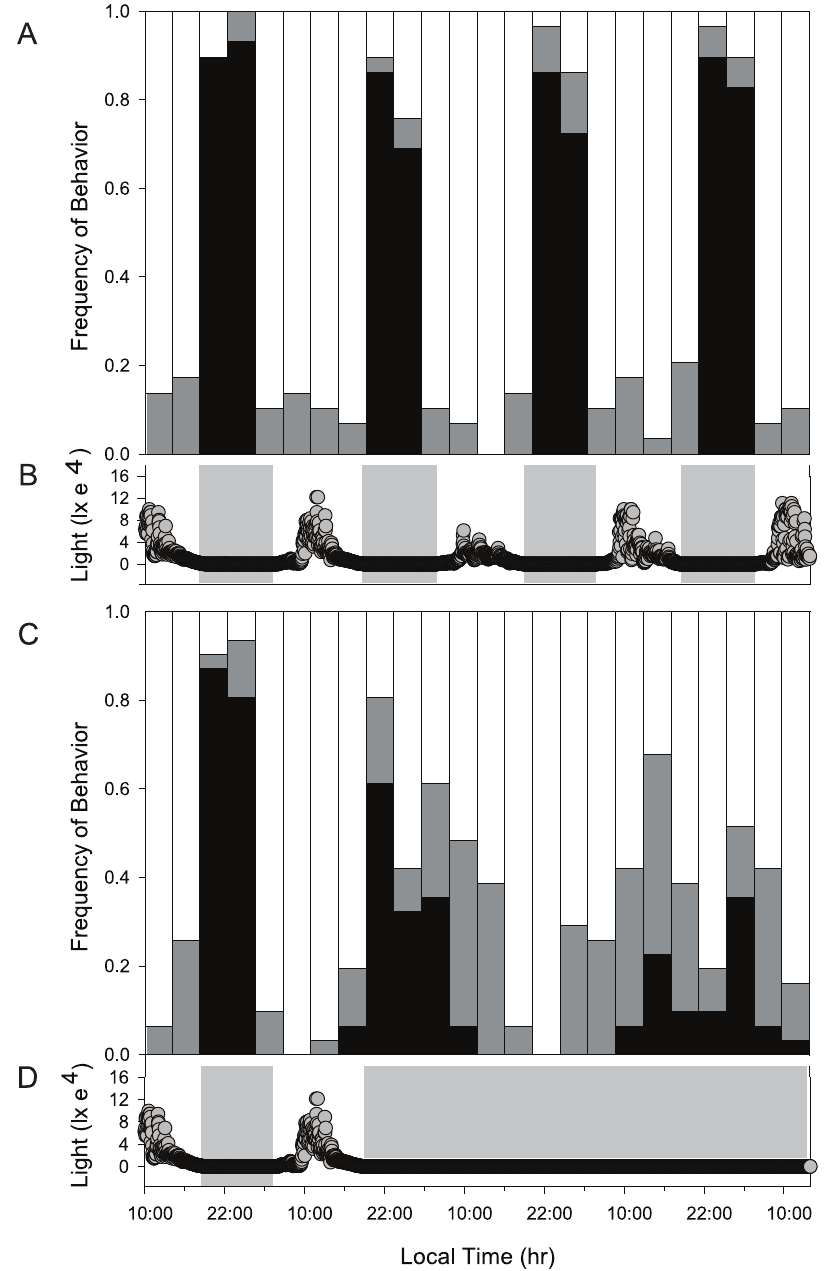
Figure 4. Diel polyp expansion and contraction in F.fragum in light:dark and constant dark treatments. The fraction of colonies with contracted (white), partially expanded (gray), or fully expanded (black) in light:dark (A; n=29) and constant dark (C, n=31) treatments. Light levels (lx) were measured every 5 min for light:dark (B) and constant dark treatments (D). Horizontal gray bars indicate dark periods.